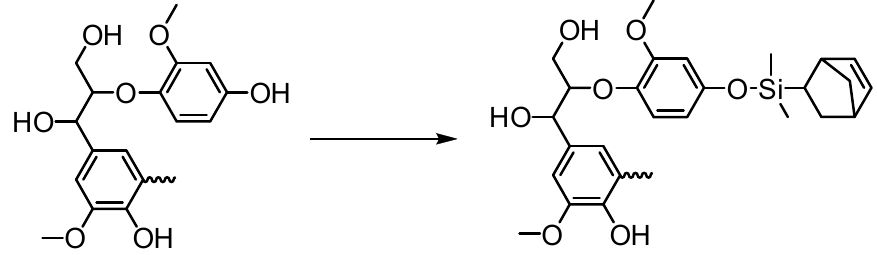
Figure 30. Lignin-based ROMP macroinitiator structure before a ruthenium catalyst is covalently attached [100].